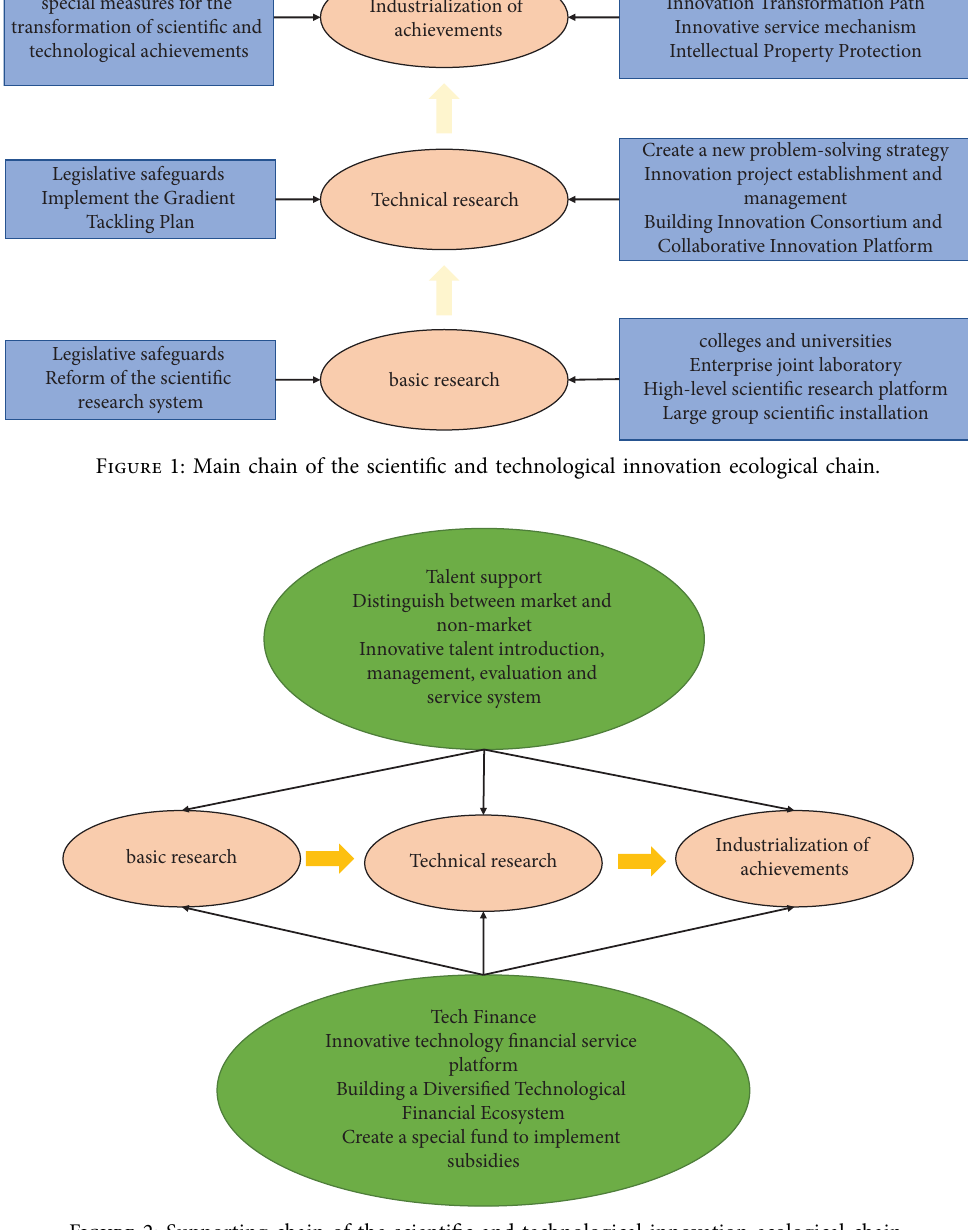
Figure 2: Supporting chain of the scientifc and technological innovation ecological